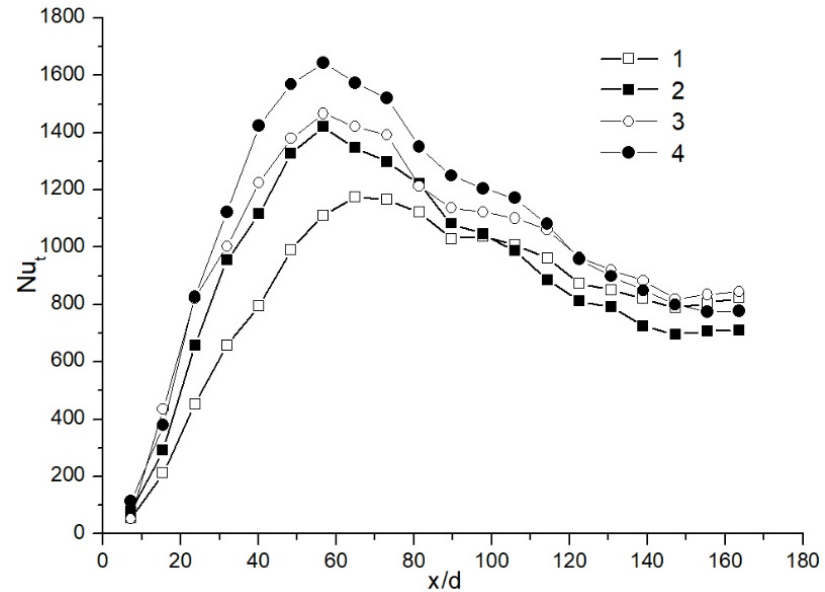
Figure 11. Distribution of the total local Nusselt number along the model of the condensing heat exchanger at Re in ≈ 21,000 for the different inlet flue gas and injected water temperatures: (1) t in ≈ 97 °C and injected water temperature 25 °C, (2) t in ≈ 103 °C and injected water temperature 40 °C, (3) t in ≈ 135 °C and injected water temperature 25 °C, (4) t in ≈ 138 °C and injected water temperature 40 °C. For the lower flue gas inlet temperature ( ≈ 97–103 °C), results show that for both in- jected water temperatures (Figure 11, curves 1 and 2), heat transfer increases rather steeply